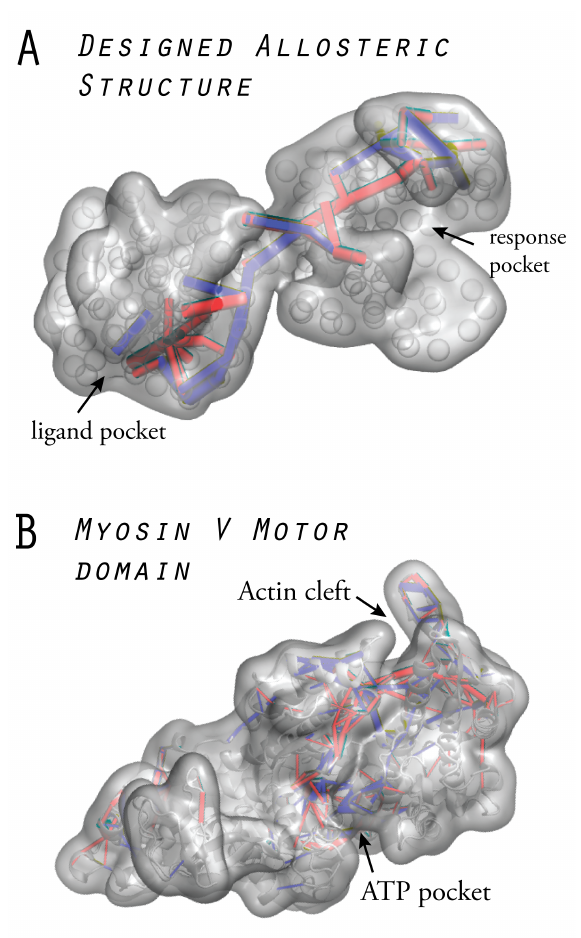
Figure 6. Allosteric structures: ( A ) A designed elastic network which encodes optimal long-range communication between two distant pockets represents a fictitious allosteric protein structure. ( B ) The myosin-V motor domain in which allosteric regulation between the ATP-binding pocket and the actin interaction cleft is essential for mechanochemical coupling. Both structures are shown in the surface representation, and the identified communication pathways are highlighted. Results from Reference [20] are incorporated into both